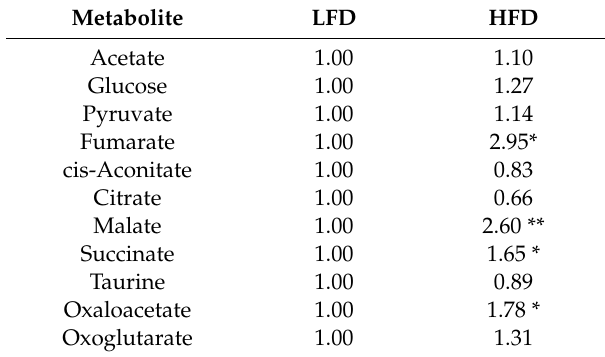
Table 1. Fold change of the metabolite levels in liver. A fold change of > 1.5 or < 0.66 was considered qualitatively important. Significance levels tested by one-way ANOVA with Benjamini–Hochberg